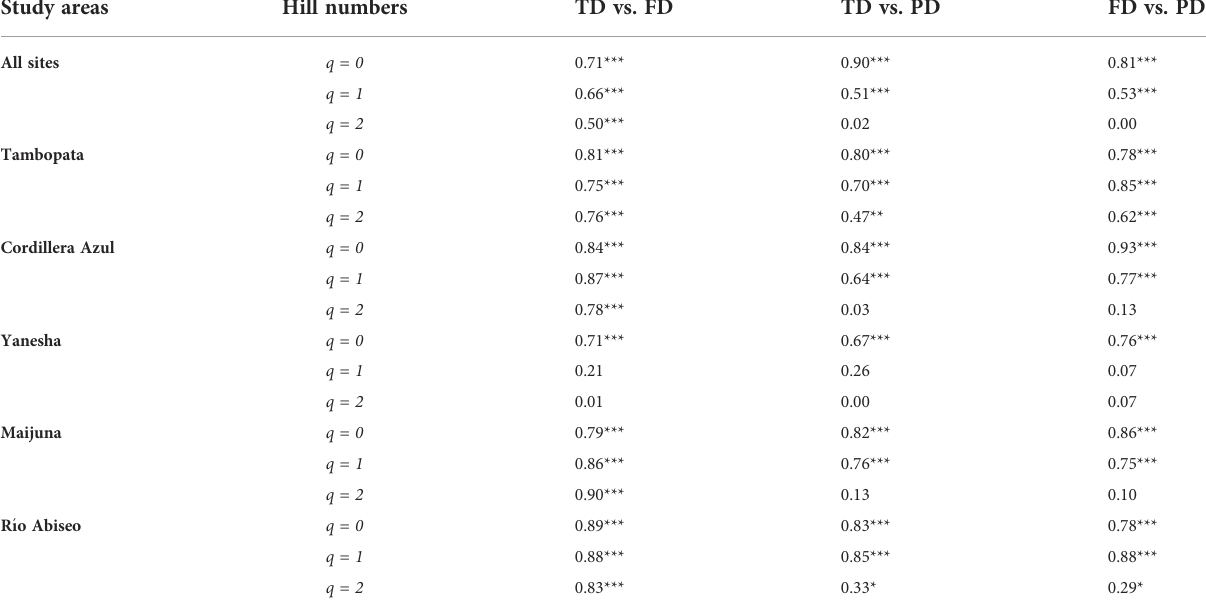
TABLE 1 Pseudo R-squared ( pR 2 ) values for negative binomial generalized linear models (GLMs) between diversity attributes for different Hill numbers: taxonomic diversity (TD), functional diversity (FD), and phylogenetic diversity (PD). Study